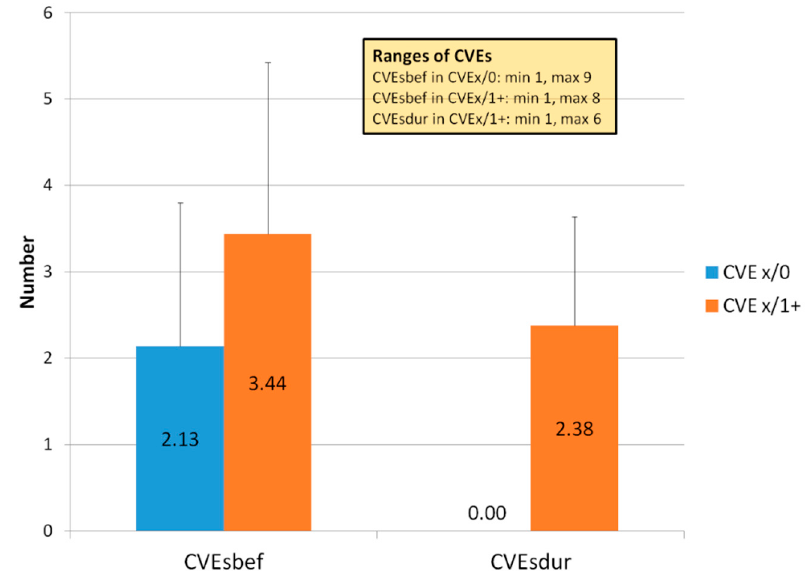
Figure 1. Number of CVEs per patient (means, standard deviations) before the start of LA therapy (CVEsbef) and during LA therapy (CVEsdur) in both groups.